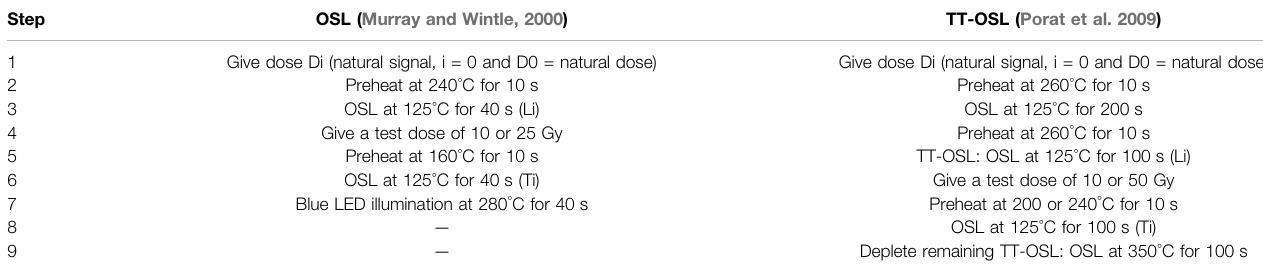
TABLE 2 | Single-aliquot regenerative-dose (SAR) OSL and TT-OSL protocols used to estimate equivalent doses (D e ) from quartz aliquots in this study. Step OSL (Murray and Wintle, 2000) TT-OSL (Porat et al. 2009)